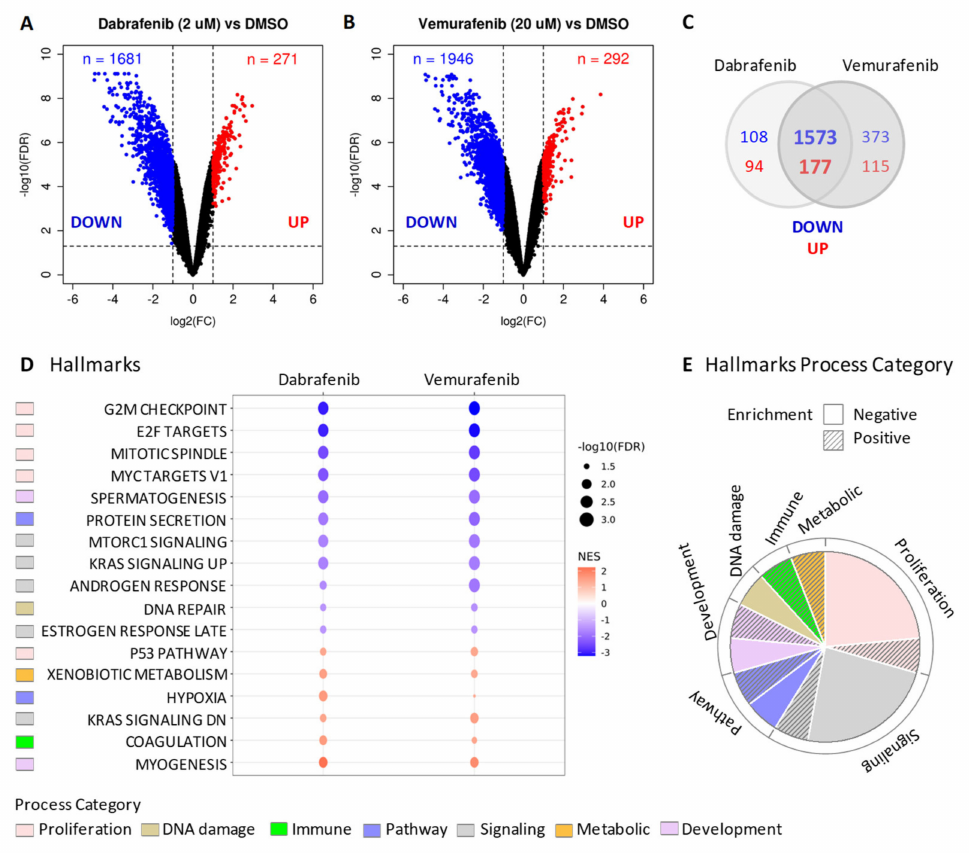
Figure 4. Gene expression profiles in BCPAP cells treated with BRAF inhibitors. ( A , B ) Volcano plot of differentially expressed genes between either Dabrafenib or Vemurafenib treated BCPAP cells compared to control cells treated with DMSO. The x -axis shows the log2 fold change (FC) and the y -axis shows the − log10 false discovery rate (FDR). The vertical and horizontal dashed lines represent the FC and FDR thresholds (absolute FC > 2 and FDR < 0.05, respectively) used to select differentially expressed genes. Up- and down-regulated genes in each comparison are highlighted in red and blue, respectively. ( C ) Venn diagram showing the intersection of statistically significant deregulated genes selected with cutoffs on absolute FC > 2 and FDR < 0.05. ( D ) Dot plots showing commonly significantly enriched gene sets (FDR < 0.05) from GSEA Hallmarks collection. The red-to-blue colored-scale bar represents the normalized enrichment score (NES). The point size indicates the magnitude of the statistical significance expressed as –log10 of the FDR. ( E ). Distribution of Hallmarks process categories relative to gene sets showed in ( D